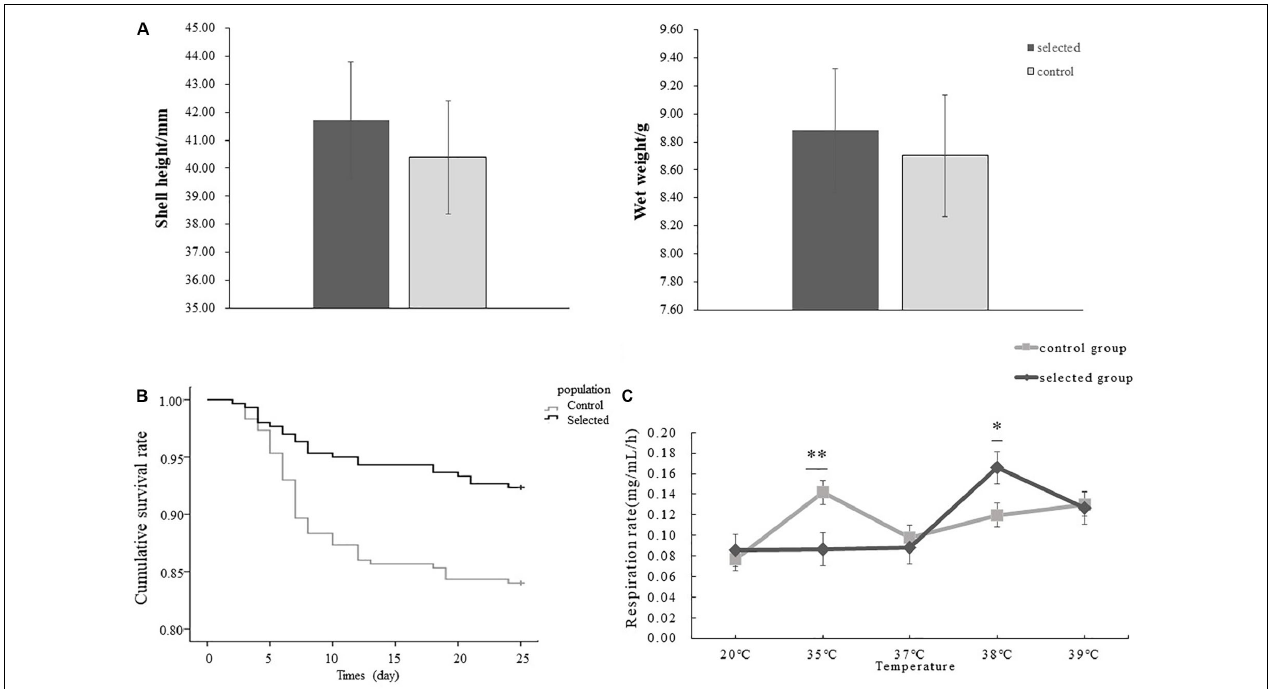
FIGURE 3 | Comparison of growth and heat tolerance between selected and control populations, respectively, and comparison of the effect of elevating temperature on respiration between two populations. The error bar denotes the standard error of the mean. ∗ indicated p < 0.05, ∗∗ indicates p < 0.01. (A) The shell height and wet height of selected and control populations, respectively ( n = 150 per population). (B) The survival rates of selected oysters and control oysters after heat shock at 42 ◦ C for 1 h ( n = 300 per population). (C) The effect of increasing temperature on the respiration between selected oysters and control oysters ( n = 6, six oysters from each population were used for each